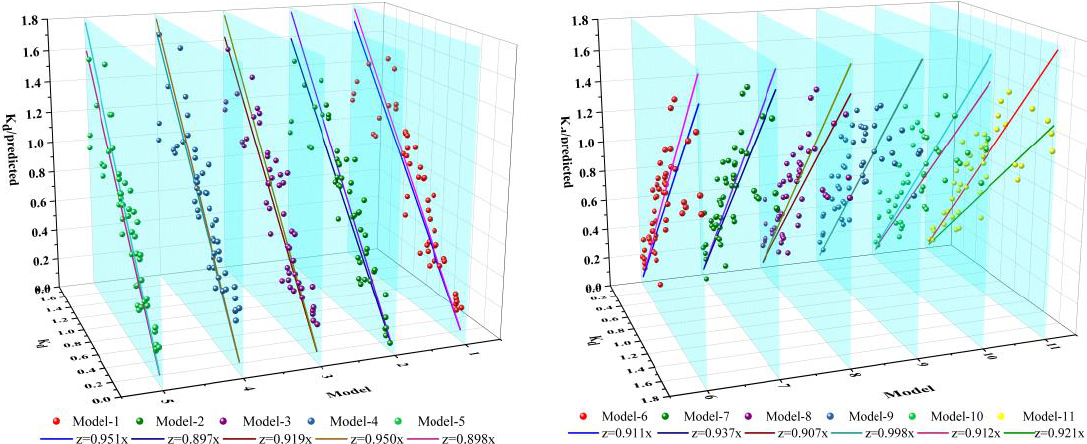
Figure 3. Correlation between experimentally obtained K d values and predicted K d values.